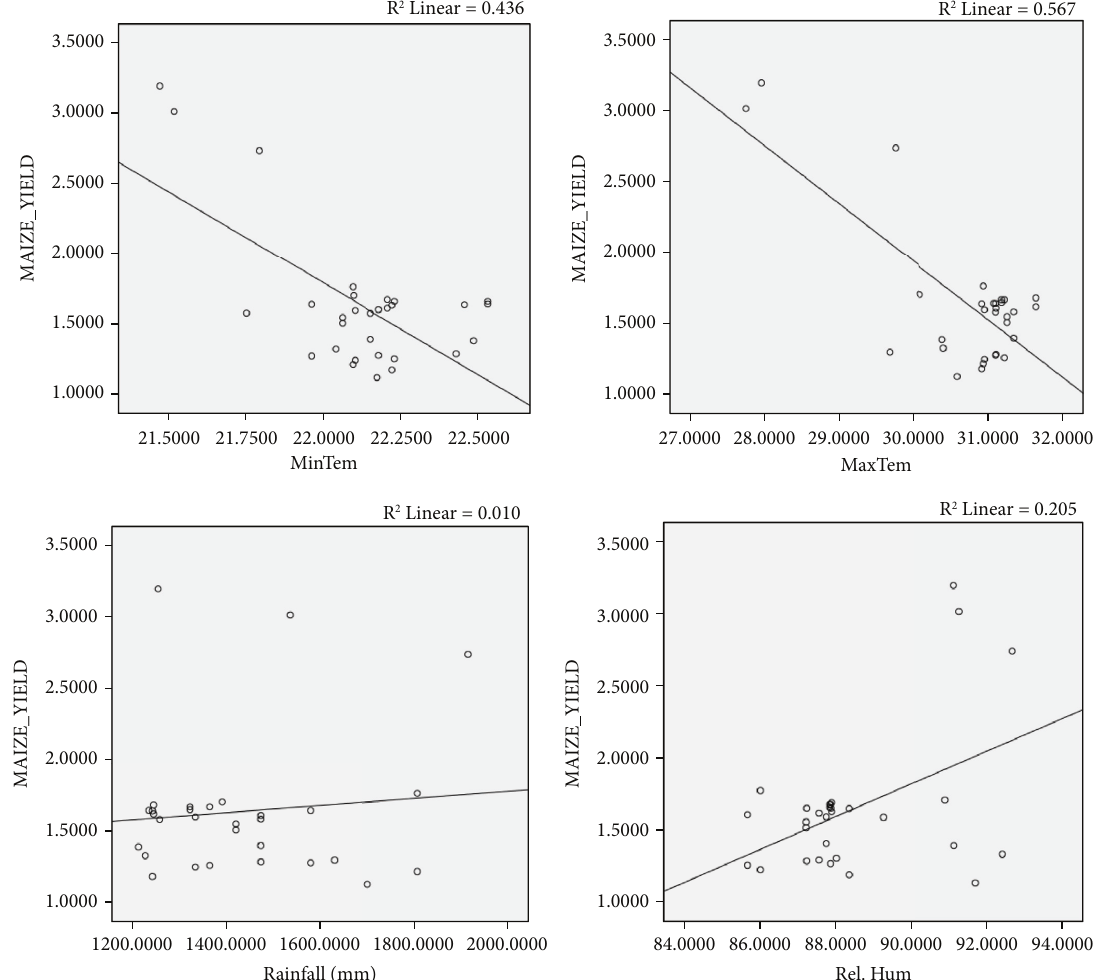
Figure 6: Scatter plot of maize yield on each climatic